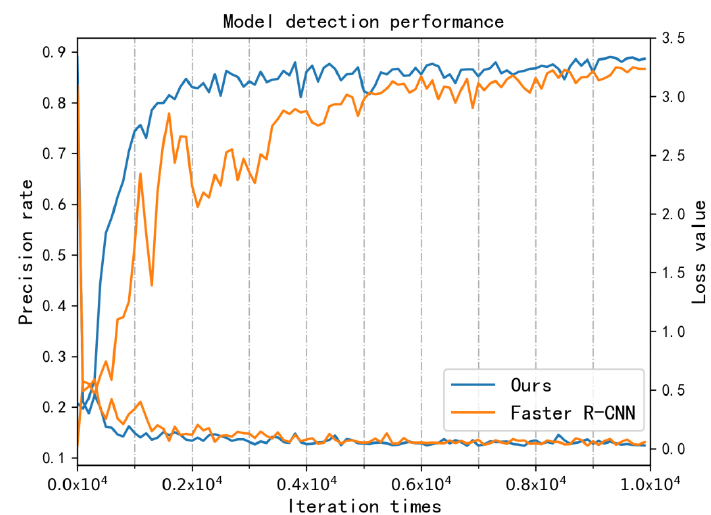
Figure 10. Comparison of the precision rate and loss function values between the two models.